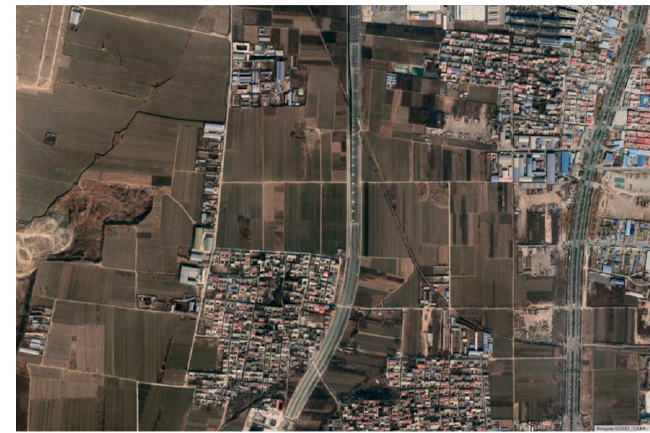
Figure 12. Path tracking control vehicle hardware system.